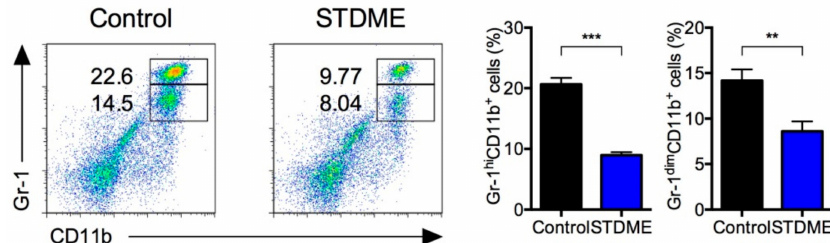
Figure 3. Suppression effect of splenic MDSCs in STDME-fed mice after AOM/DSS-induced CAC. Splenocytes from control or STDME-fed CAC-induced mice were isolated. The expression levels of Gr-1 on CD11b + cells were analyzed by flow cytometry. Each bar represents mean ± SEM and data were assessed by a Mann-Whitney U -test. ** p < 0.01; *** p < 0.001; ns = not significant; n = 10/group. STDME, selenoneine-containing tuna dark muscle extract.